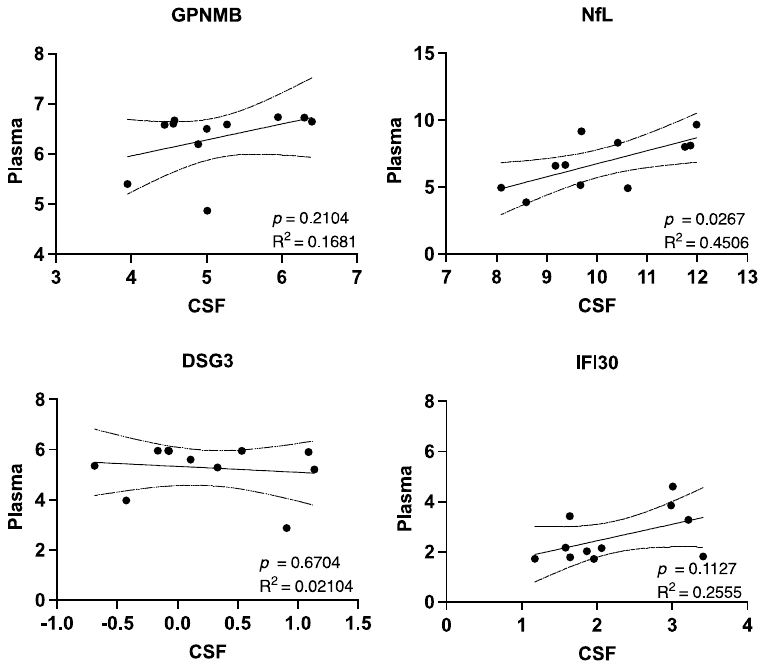
Figure 2. Correlation between CSF protein and plasma protein NPX values determined from Olink Neurology Exploratory Panel. R 2 and p -values were derived from a simple linear regression. Dotted lines indicate the 95% confidence intervals.